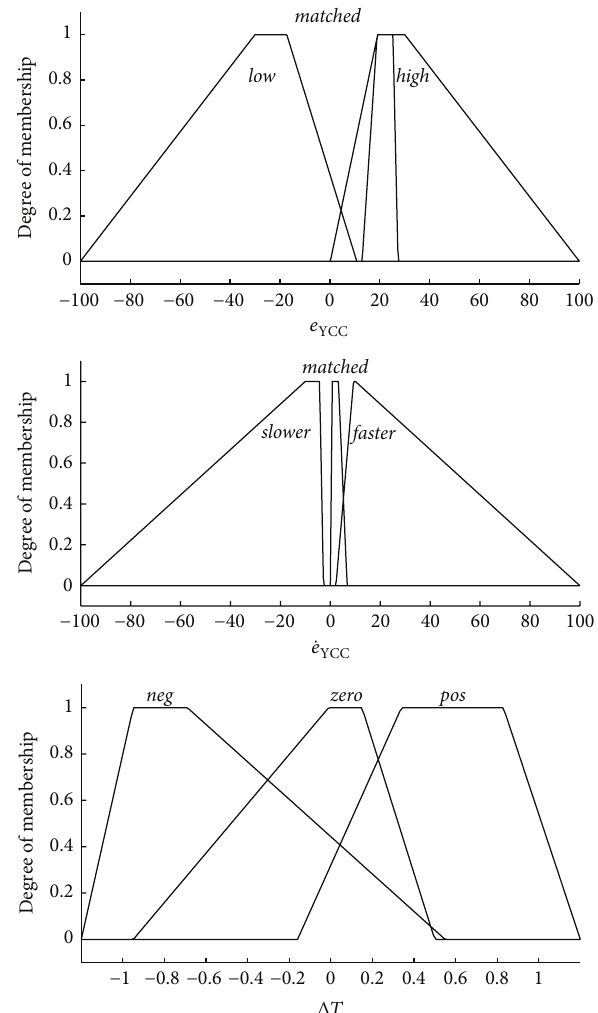
Figure 5: New set configuration of the fuzzy controller after the genetic tuning process. Slopes, shapes, and positions of the sets were changed. In particular, the sets denoted as matched were generally